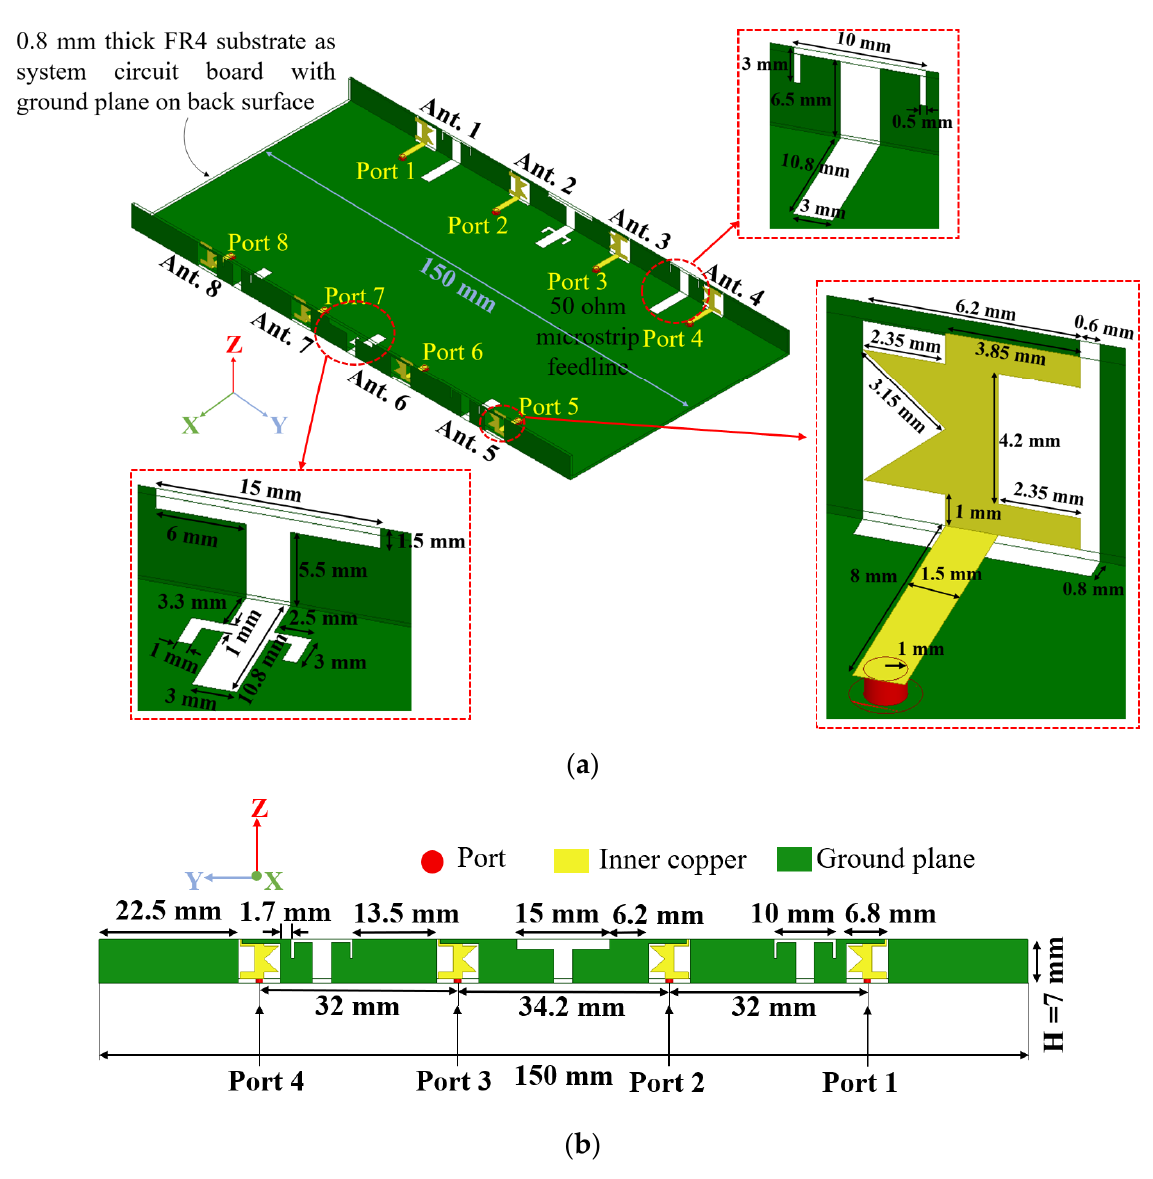
Figure 1. Composition and size of the presented wideband MIMO antenna (Unit: millimeters). ( a ) front view; ( b ) side view.